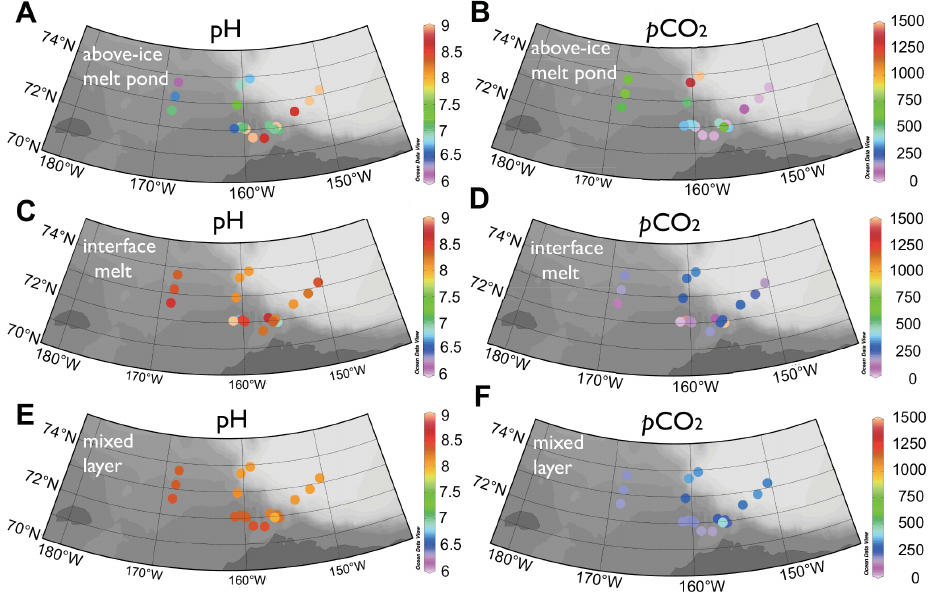
Figure 6. Surface maps of above-ice melt ponds, below-ice interface melt water, and mixed-layer values beneath each ice station sampled on 2010 and 2011 ICESCAPE cruises. (a) pH for above-ice melt ponds. (b) p CO 2 (µatm) for above-ice melt ponds. (c) pH for below-ice interface melt water. (d) p CO 2 (µatm) for below-ice interface melt water. (e) pH for mixed-layer values beneath each ice station. (f) p CO 2 (µatm).